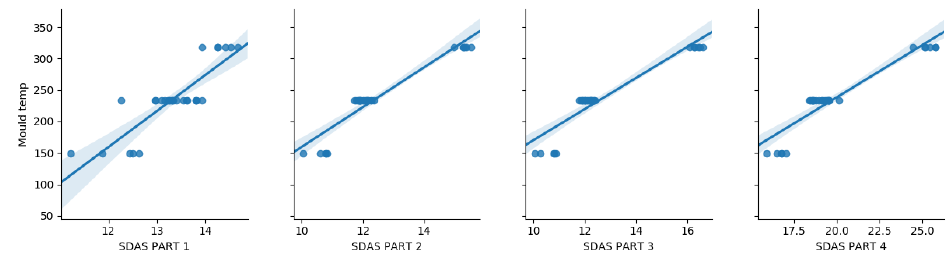
Figure 13. SDAS univariate